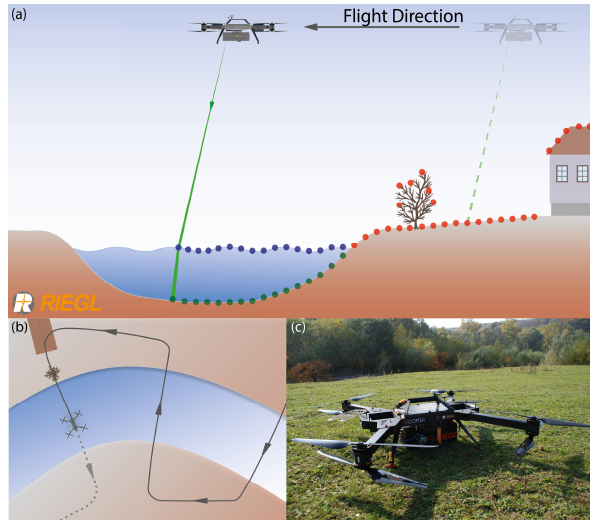
Figure 1: (a) Laser range finder mounted on UAV platform; (b) Profile oriented data acquisition; (c) BathyCopter ready for take-off at the test